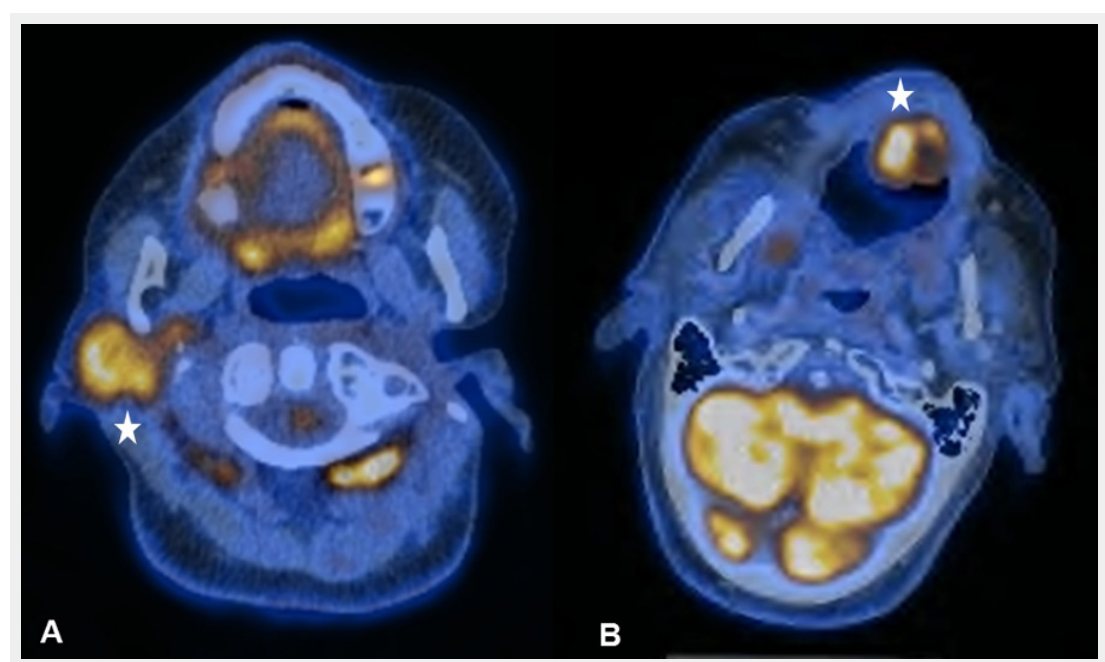
Figure 2 (A) Increased uptake in the right parotid gland in a 56-year old patient with a past medical history of radical parotidectomy and adjuvant radiation therapy (RT) on the left side due to a parotid gland carcinoma. Physiological uptake in the cervical brown fat tissue and the floor of mouth (FOM) muscles. (B) Increased uptake in the left paramedian FOM muscles due to muscular dysbalance in a 69-year old patient with a past medical history of surgical resection and RT of a right-sided base of the tongue